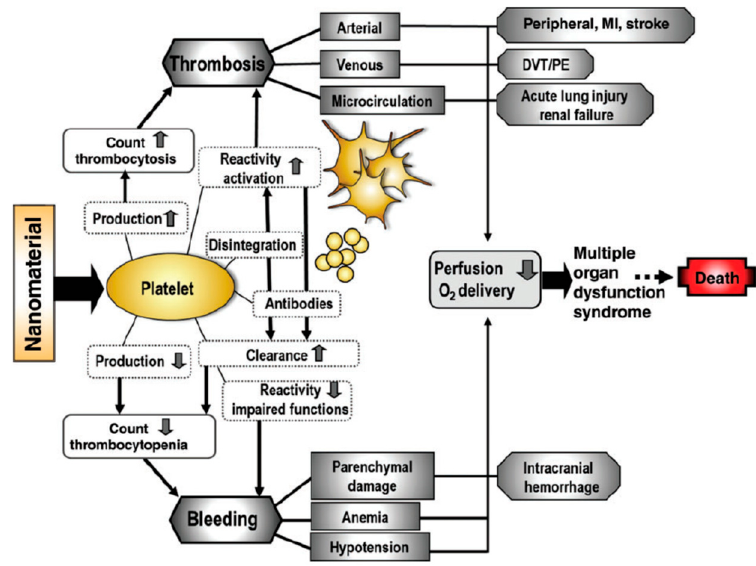
Figure 4. The potential in vivo adverse effects resulting from nanomaterial interactions with blood platelets. Abbreviations: DVT, deep venous thrombosis; MI, myocardial infarction; PE, pulmonary embolism [65].